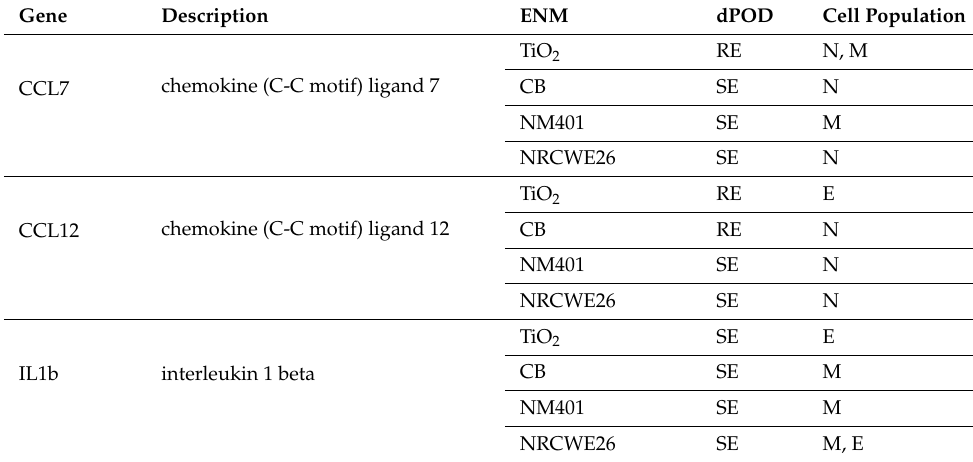
Table 2. Genes that are dose-dependent in all the ENMs and are correlated to at least one cell population. In dPOD column: RE stands for resilient-early, SE stands for sensitive-early. In cell population column: N stands for neutrophils, M stands for macrophages, E stands for eosinophils.